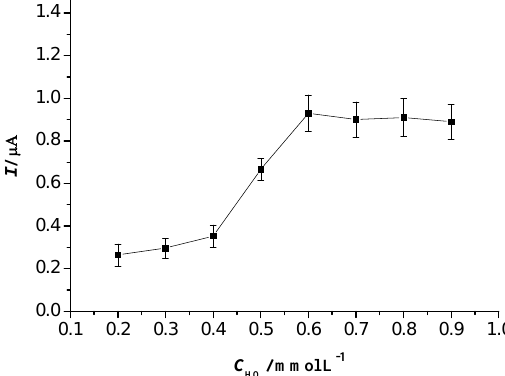
Figure 3. Effect of HQ concentration on the biosensor response to 5.0 × 10 -4 M H 0.15 M pH 8.0 PBS.